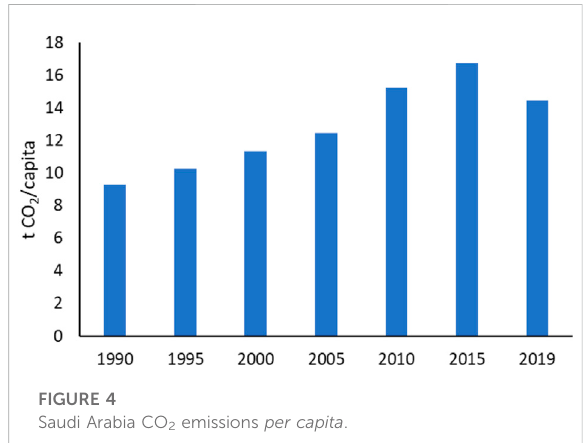
FIGURE 4 Saudi Arabia CO 2 emissions per capita